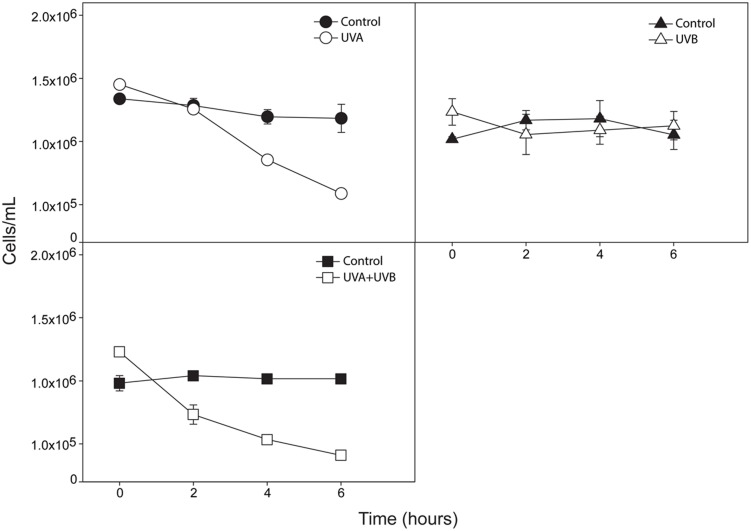
Cell concentration evaluation after 6 h of exposure to ultraviolet radiation (UVA, UVB, and UVA + UVB). For each time point, the concentrations of UV-treated cultures (UVA, n = 3; UVB, n = 3 and UVA + UVB, n = 3) and their respective controls (total n = 9) were analyzed after fixation and cells counted by light microscopy using a hemocytometer. All cultures were in the exponential phase of growth. Data are expressed as mean ± SD (n = 3). Open symbols represent treatments whereas filled symbols represent control groups.